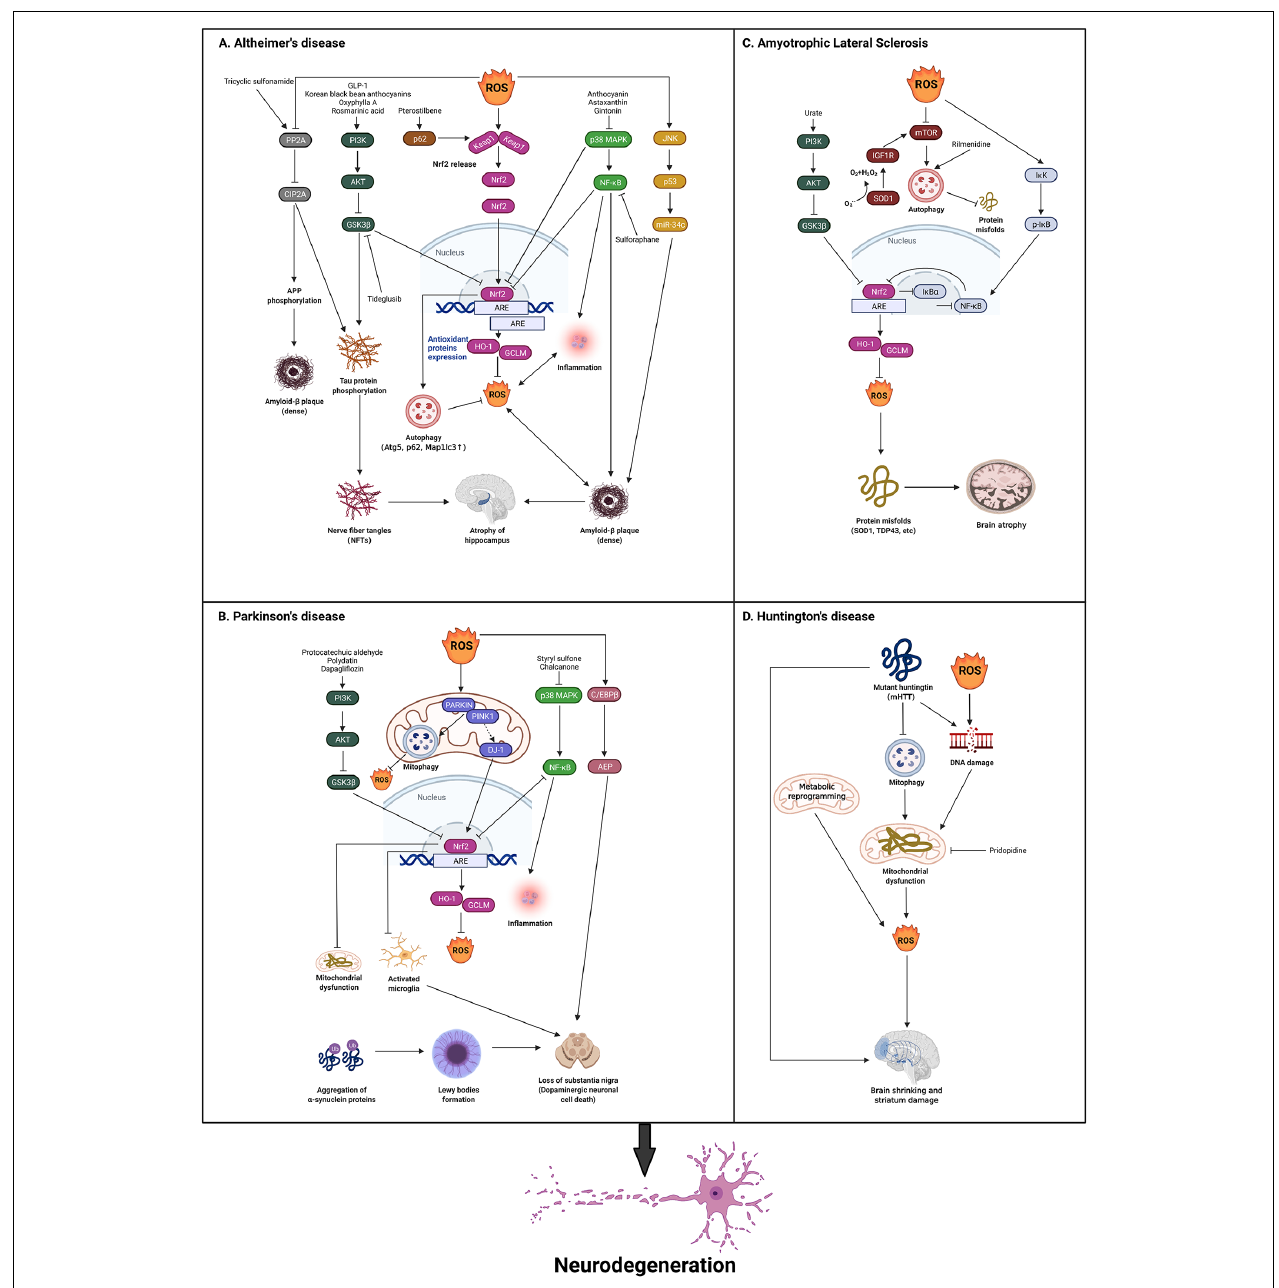
FIGURE 2 | The roles of reactive oxygen species (ROS) in neurodegenerative diseases. The presence of hallmark protein(s) for each neurodegenerative disease is a common trait, such as Tau and A β in AD, α -synuclein in PD, TDP-43, and SOD1 in ALS, and mHTT in HD. (A) In AD, ROS production serves both as a stimulus and a consequence of activated Nrf2 via PI3K/AKT/GSK3 β , p62, p38 MAPK/NF- κ B pathways, which is demonstrated to closely correlates with AD pathogenesis. Besides, ROS induced AD development through the inhibition of PP2A/CIP2A and the activation of JNK/P53 pathways. Some corresponding drugs are utilized to reverse this and exhibit some initial effects. (B) In PD, ROS also acts as both stimuli and a consequence of activated Nrf2 via PI3K/AKT/GSK3 β , DJ-1, and p38 MAPK/NF- κ B pathways. Additionally, ROS can activate c/EBP β /AEP pathway, which leads to dopaminergic neuronal loss and motor disorders. Some drugs are found to reverse the pathology through the above-mentioned pathways. (C) In ALS, the inhibition of GSK3 β is reported to activate Nrf2 via PI3K/AKT pathway. SOD1 is an important gene that is relevant to ROS in ALS that inhibits ROS production. ROS activates I κ K/p-I κ B/NF- κ B pathway to inactivate Nrf2. The activation of SOD1 also regulates IGF1R/mTOR pathway to inhibit autophagy which can eliminate misfolded proteins. Rilmenidine is found to reduce autophagy to alleviate ALS development. (D) In HD, mHTT blocks autophagy, and mHTT and the over production of ROS leads to DNA damage to produce ROS through mitochondrial dysfunction, which results in ALS. Metabolic reprogramming can also induce ROS production which leads to ALS. Finally, pridopidine can be found to inhibit mitochondrial dysfunction to reverse this pathology (Created with BioRender.com). AD, Alzheimers disease; PD, Parkinsons disease; HD, Huntingtons disease; ALS, amyotrophic lateral sclerosis; SOD1, Superoxide Dismutase 1; TDP-43, TAR DNA-binding protein 43; Nrf2, Nuclear factor erythroid 2-related factor 2.